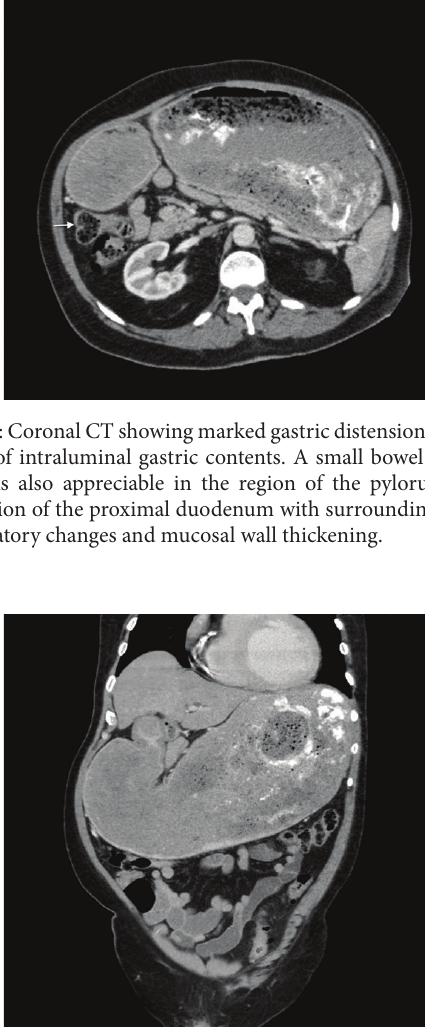
Figure 1: Chest X-ray of patient demonstrating enlarged gastric silhouette secondary to high-grade gastric outlet obstruction that could be mistaken for free air under the diaphragm.